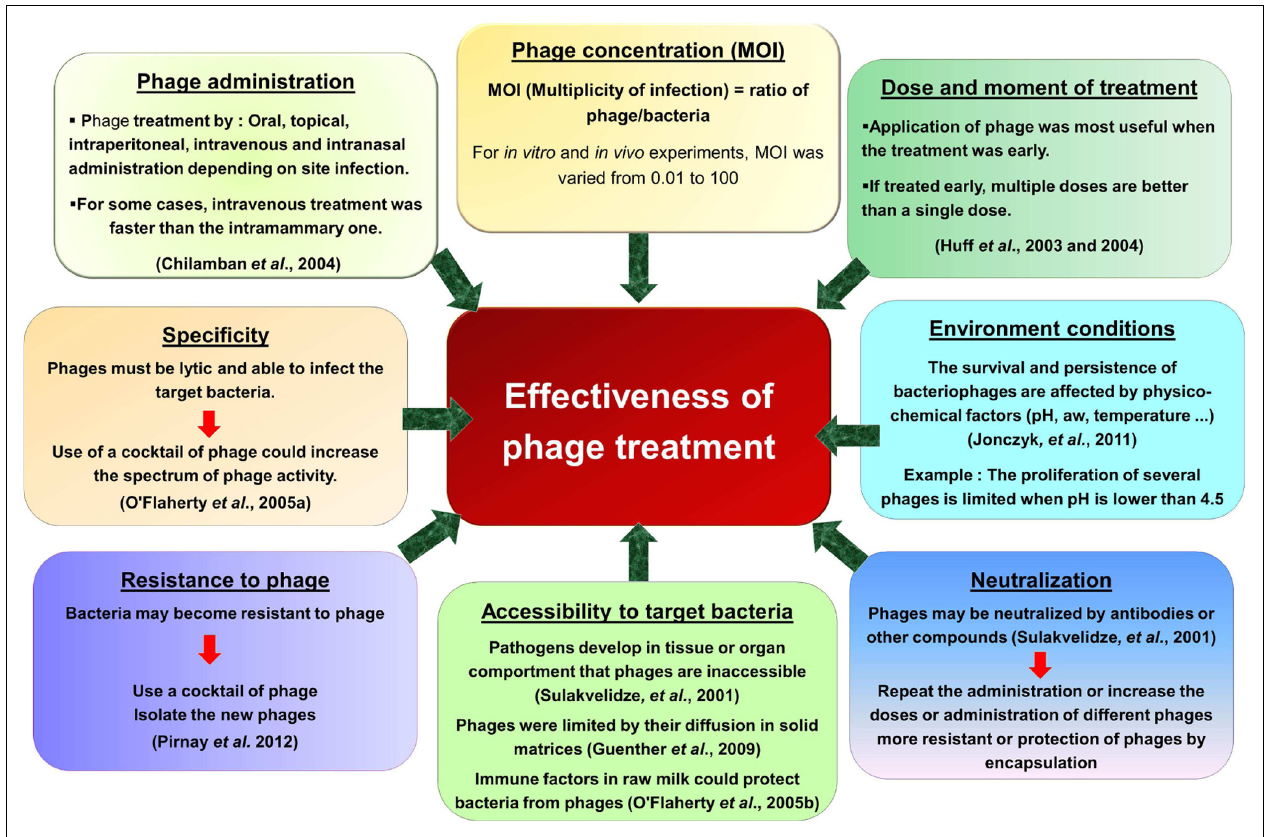
FIGURE 1 | Factors affecting the effectiveness of phage use against pathogenic